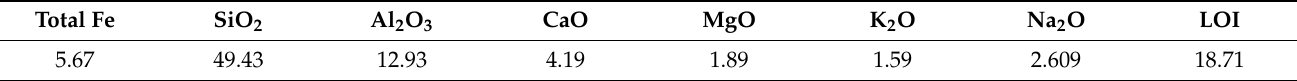
Table 4. Main chemical compositions of HAMB (wt.%).